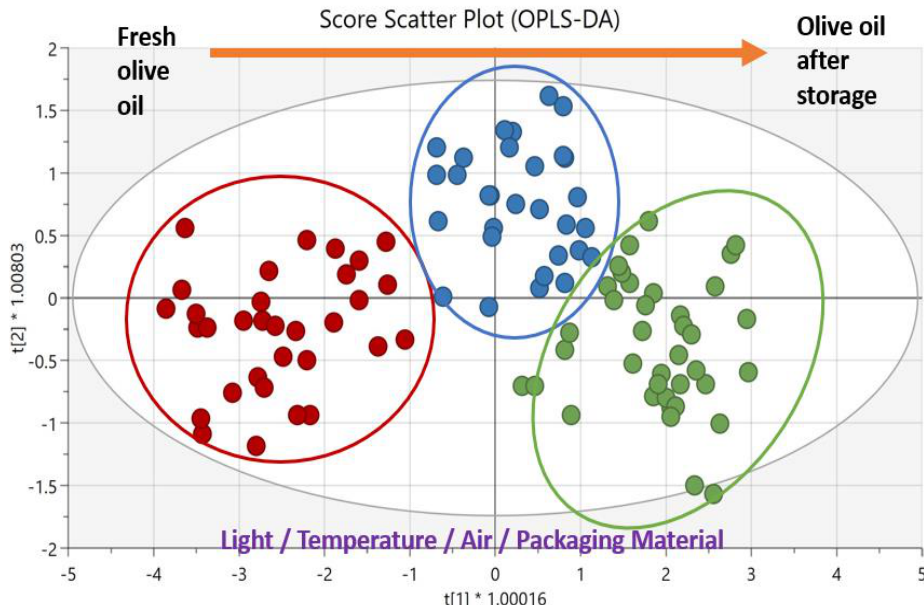
Figure 1. Score scatter plot obtained after chemometric analysis based on the OPLS-DA method. The presentation of fresh olive oil vs. olive oil after storage, classified in 3 groups, and the parameters that affect quality.